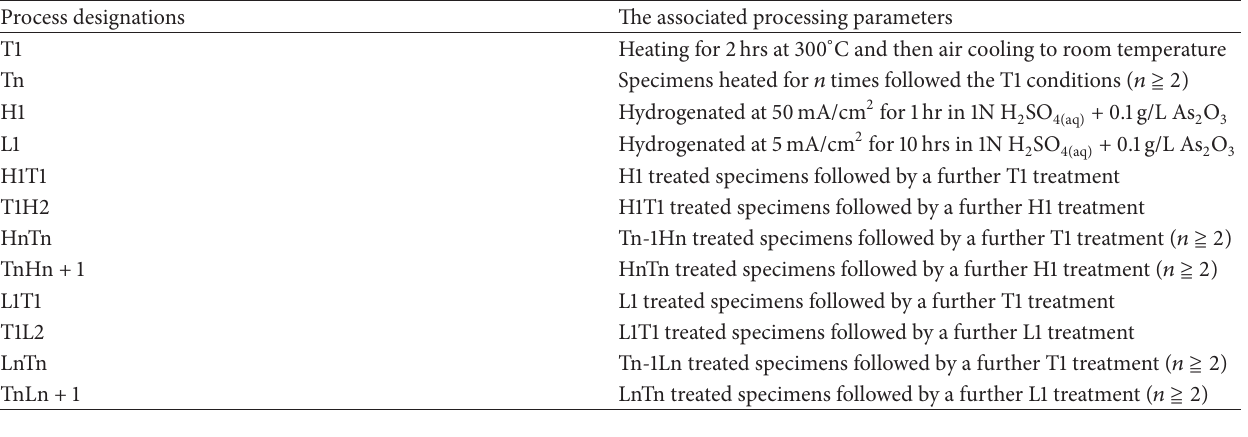
Table 3: Process designations and the associated processing parameters.